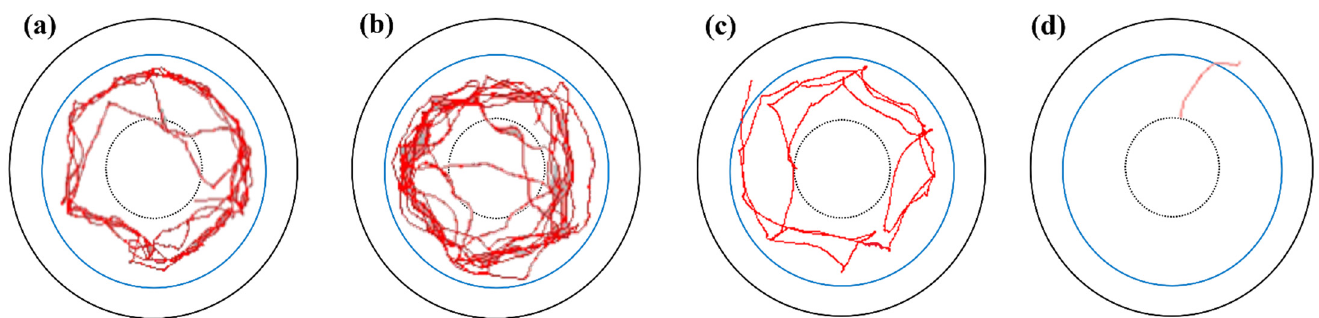
Figure 2. Representative tracks showing the behavior of Haemaphysalis longicornis nymphs on filter paper treated with phenethyl isothiocyanate ( a ), benzyl isothiocyanate ( b ), IR3535 ( c ), or negative control (ethanol) ( d ) on the outer circle (i.e., outside the blue line).